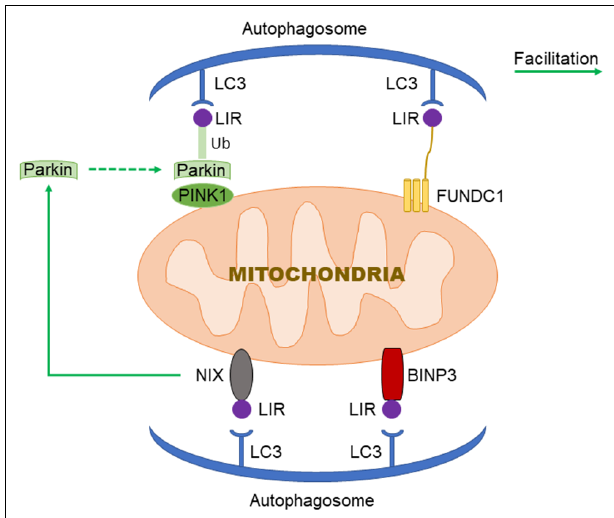
FIGURE 1 | Three signaling pathways regulating mitochondrial autophagy. In PTEN Induced Putative Kinase 1 (PINK1)/Parkin pathway, PINK1 functions as the initiator which recognizes the disturbed outer membrane potential and activates Parkin and ubiquitin phosphorylation, and then the complex is combined by LC3 to autophagosome; FUN14 Domain-Containing 1 (FUNDC1) is a three transmembrane protein having the LC3 interaction region (LIR) motif on the N-terminal which can be recognized by LC3; both BNIP3 and NIX have LIR motif, additionally, NIX can facilitate the localization of Parkin to the damaged